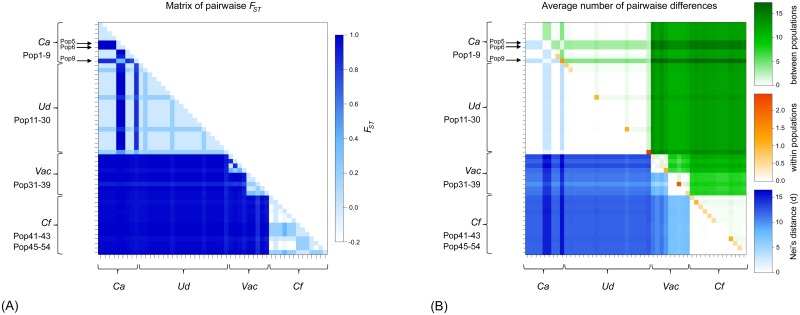
Plots representing parameters of mtDNA genetic differentiation between Hyalesthes obsoletus host-associated populations based on (A) pairwise FST values and (B) Nei’s average number of pairwise differences.Associated host-plants: Convolvulus arvensis (Ca), Urtica dioica (Ud), Vitex agnus-castus (Vac), and Crepis foetida (Cf). Populations are listed in the same order as in Table 1. The three populations marked with arrows show genetic differentiation compared to all others in the same host-associated group (Ca-Ud). The blue elements below the diagonal of FST values range from 0 to 1, with 0 (including < 0) indicating no divergence between the populations and 1 indicating that two populations are completely separated. The green elements above the diagonal denote Nei’s average number of pairwise differences among populations, the orange diagonal elements denote Nei’s average number of pairwise differences within populations, and blue elements below the diagonal denote the net number of nucleotide differences among populations (Nei’s distance).